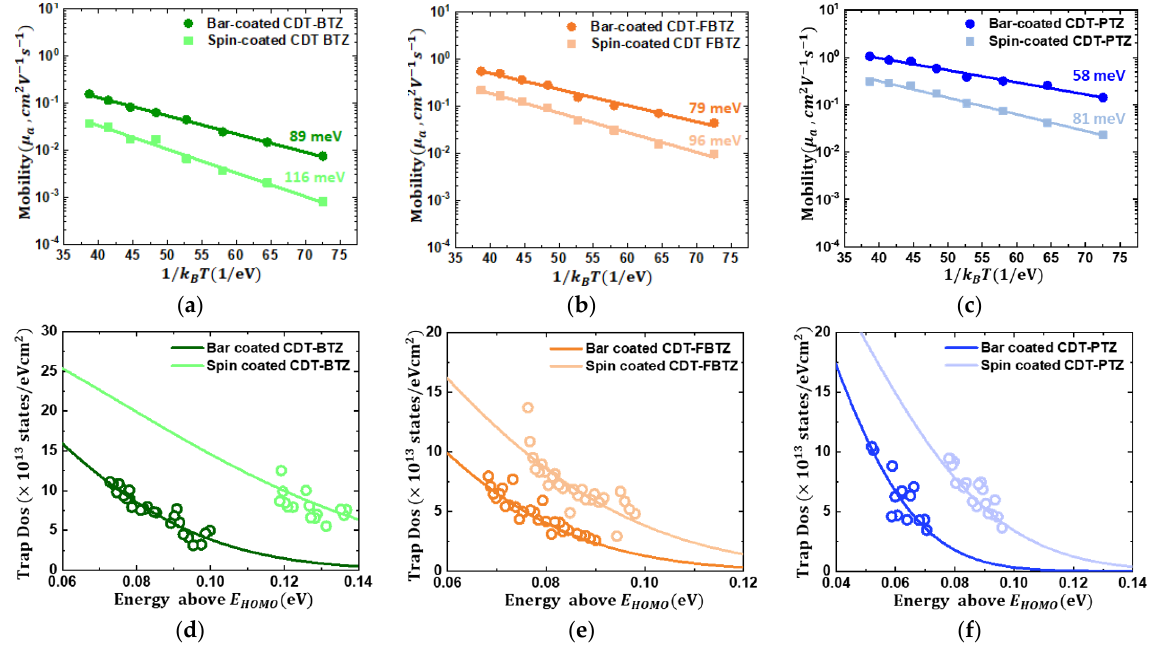
Figure 6. Linear mobility as a function of 1/ T for the spin- and bar-coated ( a ) CDT-BTZ-, ( b ) CDT-FBTZ-, and ( c ) CDT-PTZ-based PFETs. Extracted charge trap density of states (DOS) of the spin- and bar-coated ( d ) CDT-BTZ-, ( e ) CDT-FBTZ-, and ( f ) CDT-PTZ-based PFETs above the HOMO energy level, E HOMO . The DOS results were fitted to the Gaussian DOS model.